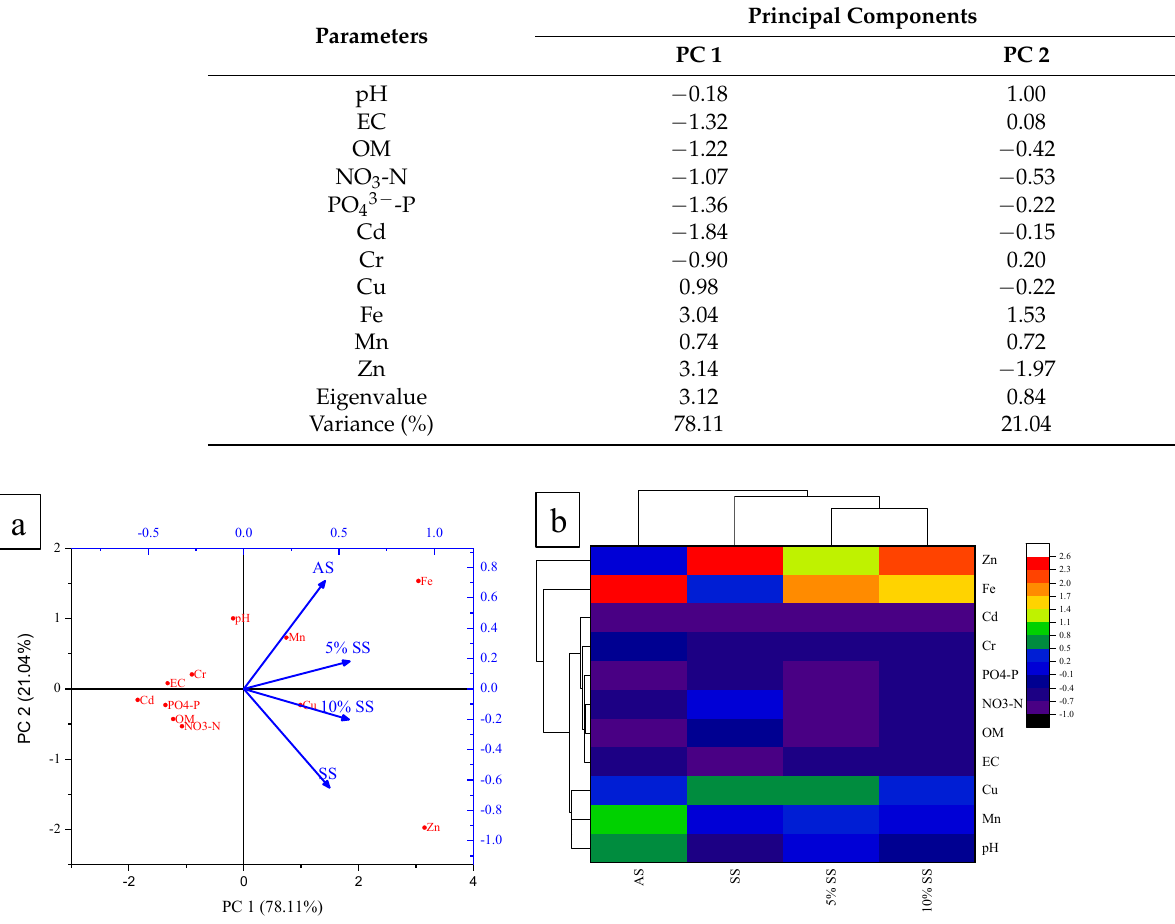
Table 2. Principal component analysis (PCA) results of interaction between arable soil, sewage sludge, and metal elements content.